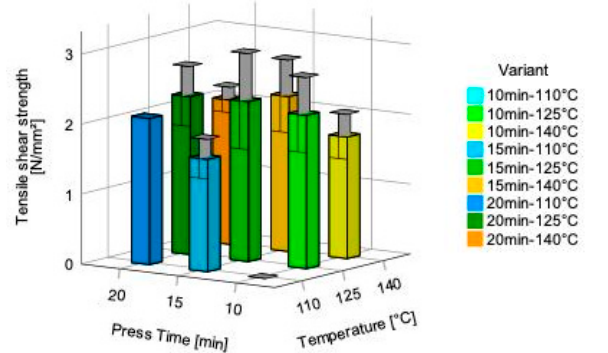
Figure 8. Dry state tensile shear strength for the 5-layered Quebracho tannin bonded plywood. The brackets within the columns of the figure indicate the standard deviation.